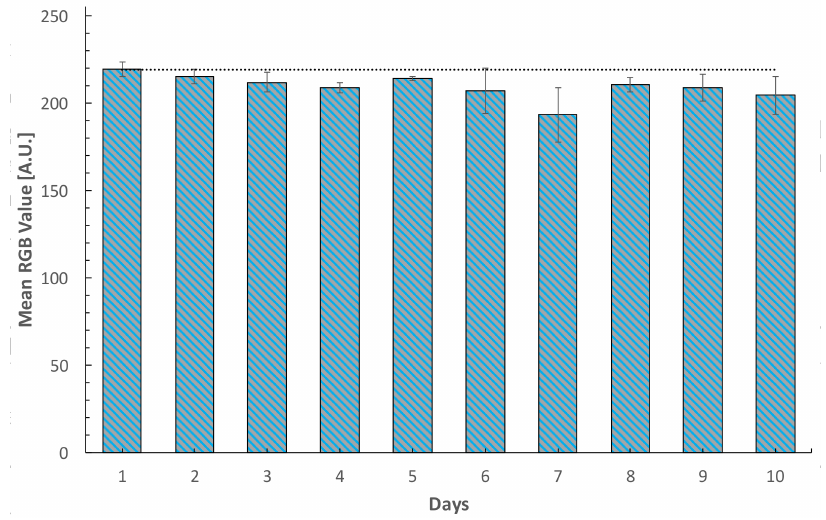
Figure 6. Stability test for fabricated paper-based sensors stored at − 4 ◦ C in dark